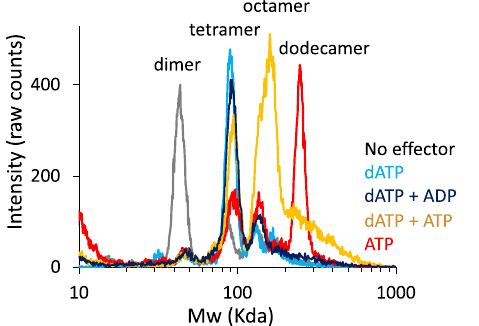
Fig. 6 Oligomeric states of NrdR. Oligomeric states of S. coelicolor NrdR loaded with nucleotides determined by GEMMA. Gray: no effector, red: ATP, light blue: dATP, orange: dATP + ATP, dark blue: dATP +